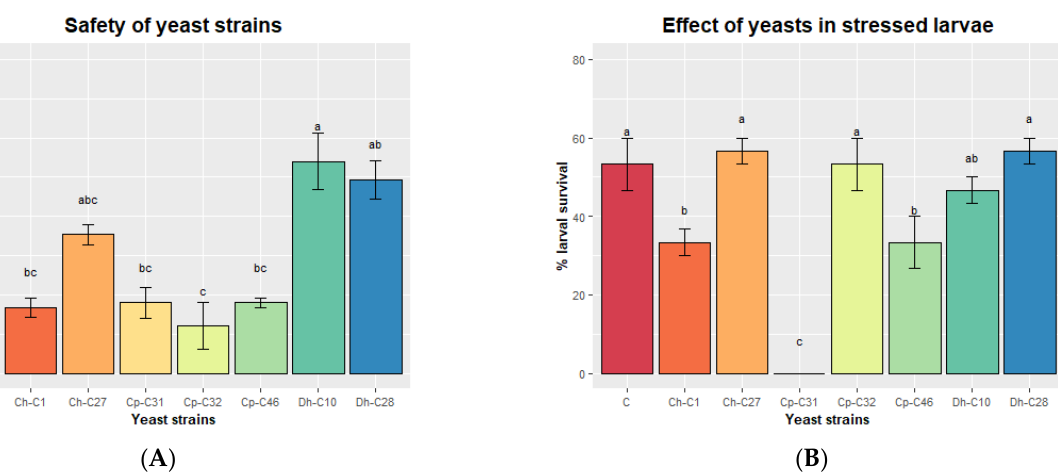
Figure 5. Effect of yeast strains on the survival of normal ( A ) and stressed larvae ( B ). ( A ) Larvae (2 dph) were exposed by immersion to yeast strains (10 7 CFU mL −1 ), and survival was monitored for 24 h. ( B ) Larvae (4 dph) were fed with rotifers ( Brachionus rotundiformis ) enriched with each yeast strain. At 6 dph, larvae were transferred to hyposaline water (5 ppt), and survival was monitored for 8 h. Data are presented as the mean ± standard error. Ch, C. haemuloni ; Cp, C. parapsilosis ; Dh, D. hansenii ; Dsp, Debaryomyces sp.; Nsp, Naganishia sp. Different letters indicate significant differences ( p < 0.05) with the control group of larvae being nonexposed to yeasts.